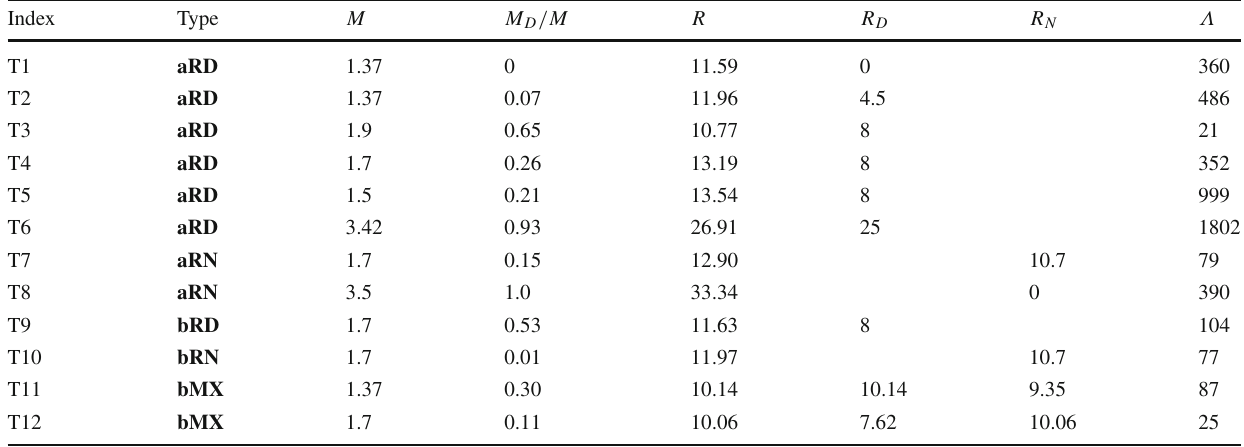
Table 1 List of 12 specific hybrid stars, most of which are indicated on Figs. 3 and 9. The first entry labels the stars, and the second entry is the type of hybrid stars as defined earlier, then the subsequent entries